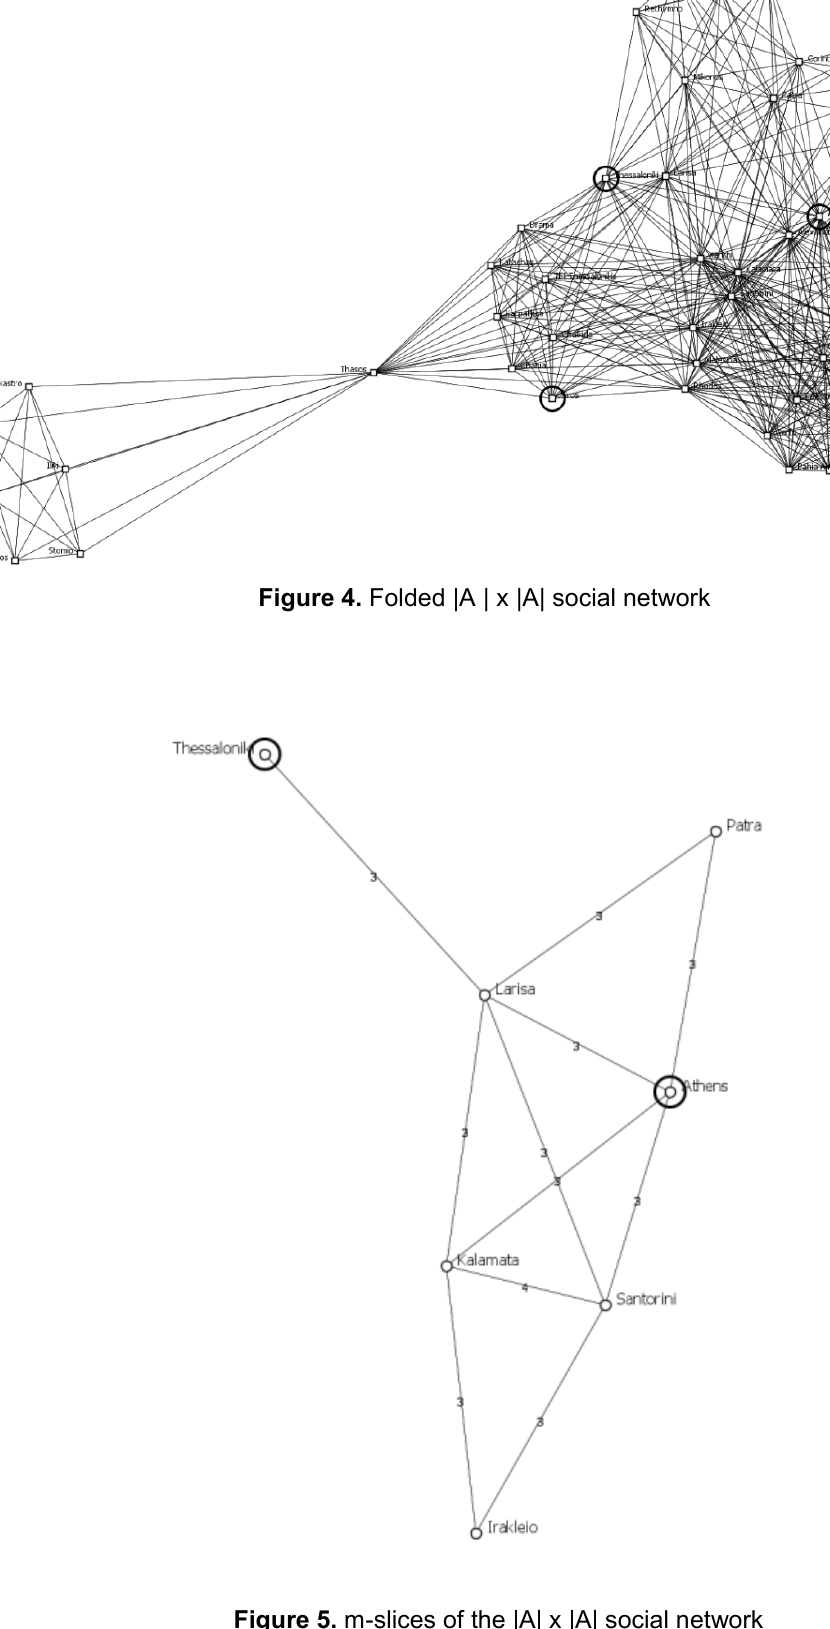
Figure 5. m-slices of the |A| x |A| social